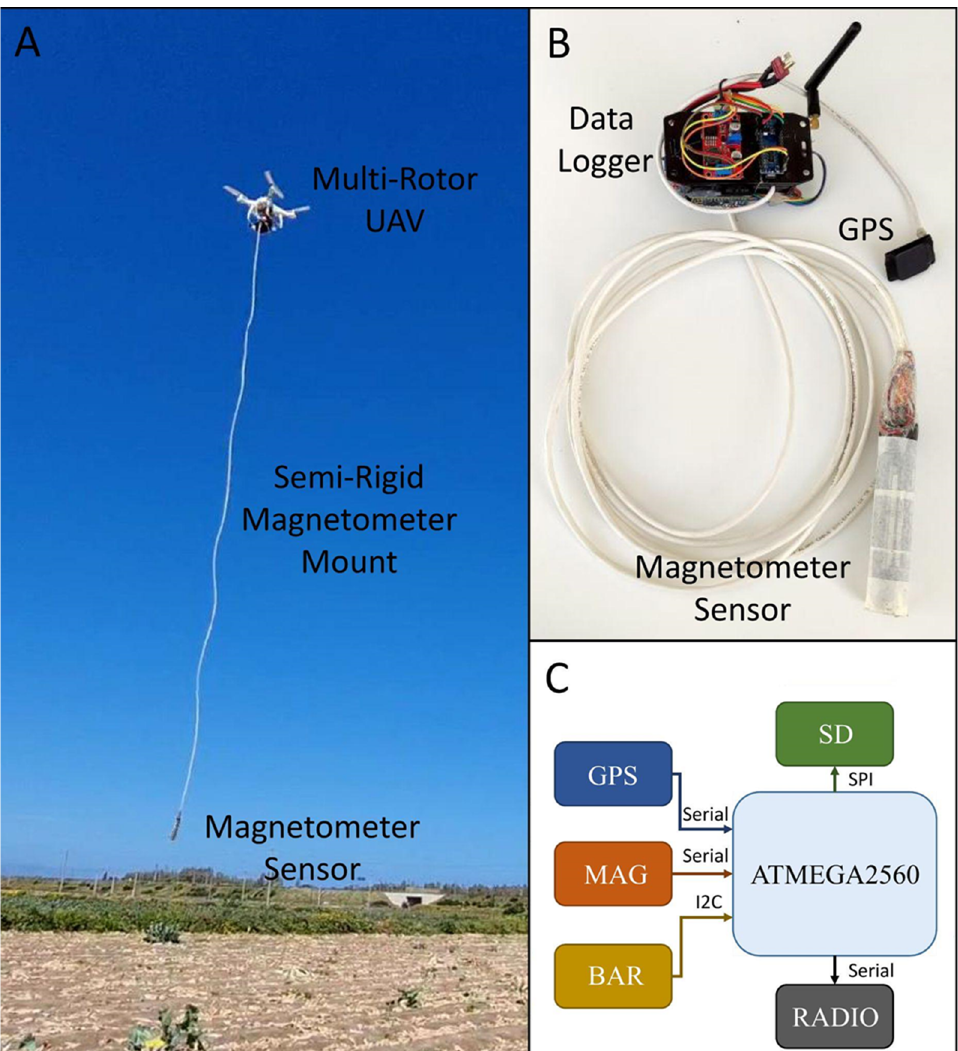
Figure 1. The unmanned aerial vehicle (UAV)-magnetometer system. ( A ) The UAV equipped with the data logger carrying the magnetometer sensor; ( B ) the magnetometer system, data logger, and sensors; ( C ) diagram of the data acquisition and control system.